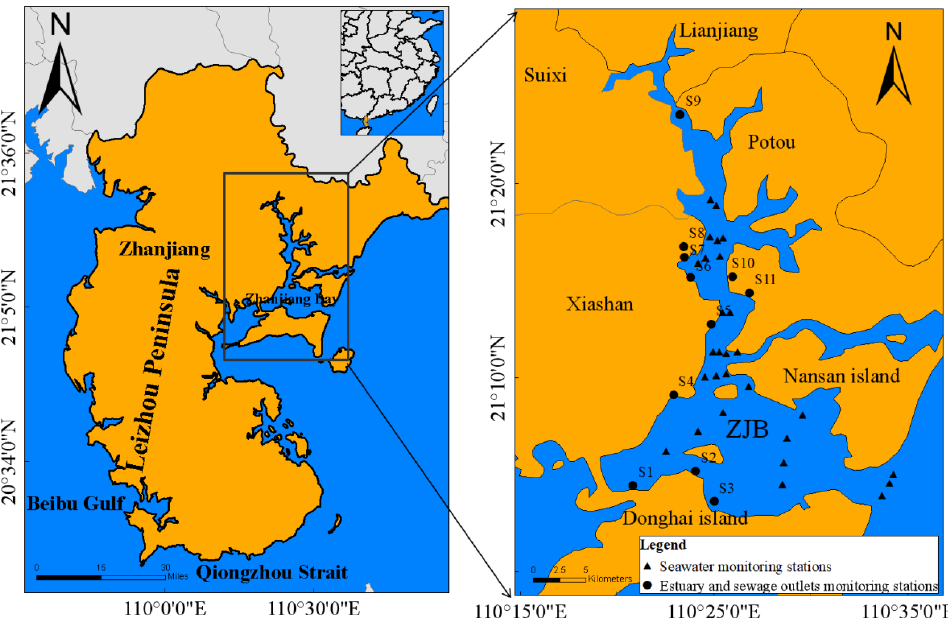
Figure 1. Geographic location, land-based sources, and coastal water monitoring stations in Zhanjiang Bay.